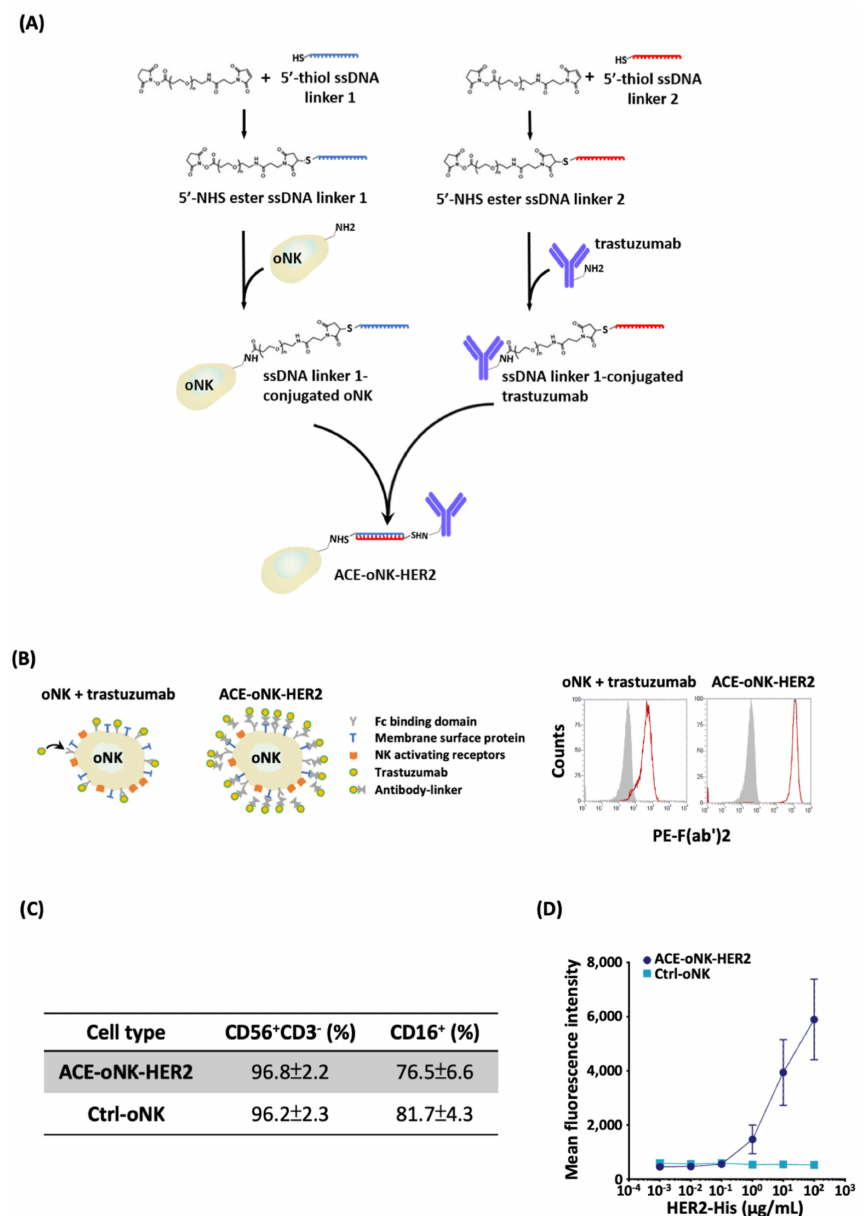
Figure 1. Trastuzumab conjugation confers oNK cells with HER2-specific binding capacity. ( A ) A flow chart of trastuzumab conjugation with oNK cells by ACC technology was illustrated. Preparation of ssDNA linker 1-conjugated oNK and ssDNA linker 2-conjugated trastuzumab was illustrated. Trastuzumab-conjugated oNK cells, ACE-oNK-HER2, were generated by co-incubation of ssDNA linker 1-conjugated oNK and ssDNA linker 2-conjugated trastuzumab. The ssDNA linker 1 and 2 were complementary. ( B ) Antibody loading capacity on the surface of oNK cells by ACC technology or Fc domain binding was illustrated (left panel) and examined using fluorescent dye-conjugated anti-F(ab’)2 antibody by flow cytometry (right panel). Negative staining (gray shaded) and trastuzumab on oNK cells (red line) were shown. ( C ) CD56 + CD3 - and CD16 + population as well as ( D ) HER2-His recombinant protein binding capacity were analyzed in both ACE-oNK-HER2 and Ctrl-oNK cells by flow cytometry. The binding capacity was determined by incubating ACE-oNK-HER2 and Ctrl-oNK cells with 10 − 3 , 10 − 2 , 10 − 1 , 10 0 , 10 1 and 10 2 µ g/mL of human HER2-His recombinant protein. Three independent experiments were performed and the representative results were shown. Each data point was performed in